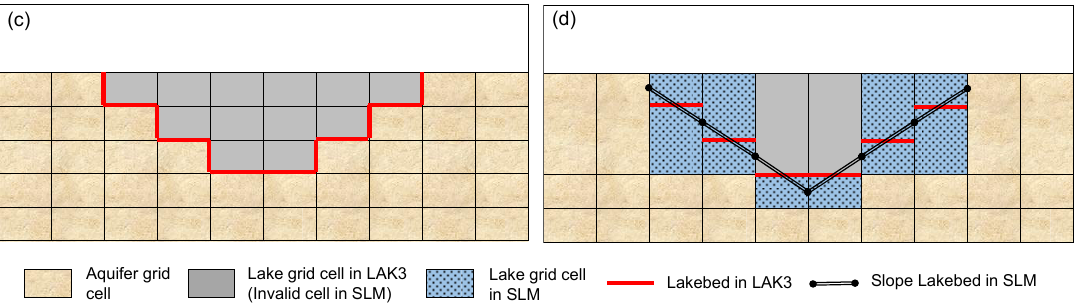
Figure 2. Conceptual models of the lake packages to be coupled with MODFLOW: ( a ) Plain view and ( b ) side view of a lake. Lakebed conceptualization using the ( c ) LAK3 method and ( d ) SLM method. For the SLM, P is precipitation, E is evaporation, W is water withdrawal, Q si is inflow from upstream rivers to the lake, Q so is outflow from the lake to downstream rivers, G in p is inflow from groundwater to the lake in the submerged area, G out p is outflow from the lake to groundwater in the submerged area, Rnf is the surface runoff generated in the unsubmerged area, G in is groundwater seepage to the unsubmerged area. For LAK3, Q rnf is the surface runoff to the lake, and sp is the net seepage between the lake and the aquifer.